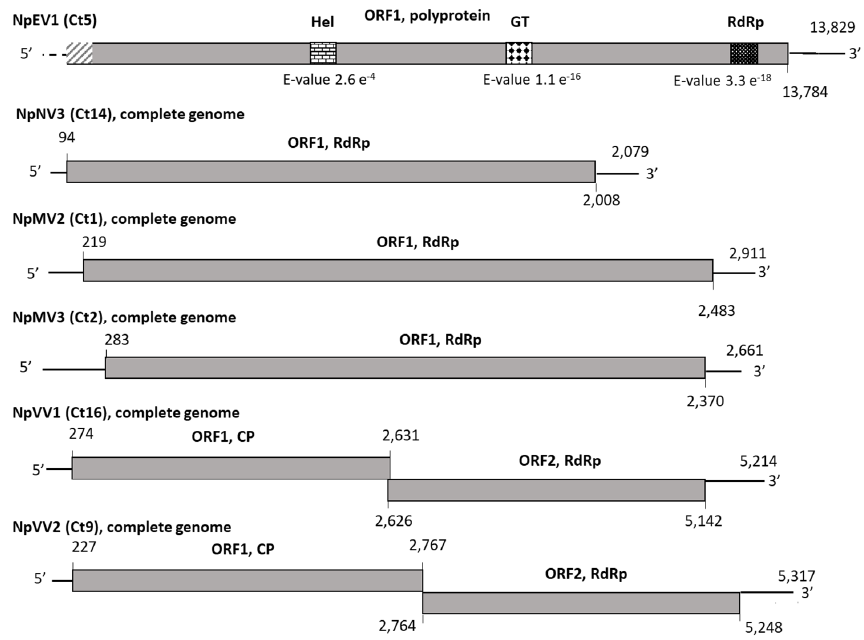
Figure 2. Genomic organization of mycoviruses identified in Neofusicoccum parvum isolates COLB. Ct 5, contig 5; NpEV1, neofusicoccum parvum endornavirus 1; Ct 14, contig 14; NpNV3, neofusicoccum parvum narnavirus 3; Ct 1, contig 1; NpMV2, neofusicoccum parvum mitovirus 2; Ct 2, contig 2; NpMV3, neofusicoccum parvum mitovirus 3; Ct 16, contig 16; NpVV1, neofusicoccum parvum victorivirus 1; Ct 9, contig 9; NpVV2, neofusicoccum parvum victorivirus 2. Numbers refer to genomic nucleotide positions. Open reading frames (ORF) are represented by boxes. Conserved RNA-dependent RNA polymerase (RdRp), RNA helicase (Hel), and glycosyl-transferase (GT) domains in the ORF1-encoded polyprotein are represented by striped shading, with the e-values associated with their identification using the conserved domain search program on the NCBI website. Missing sequences are represented by hyphenated lines (in non-coding regions) or dashed boxes (in